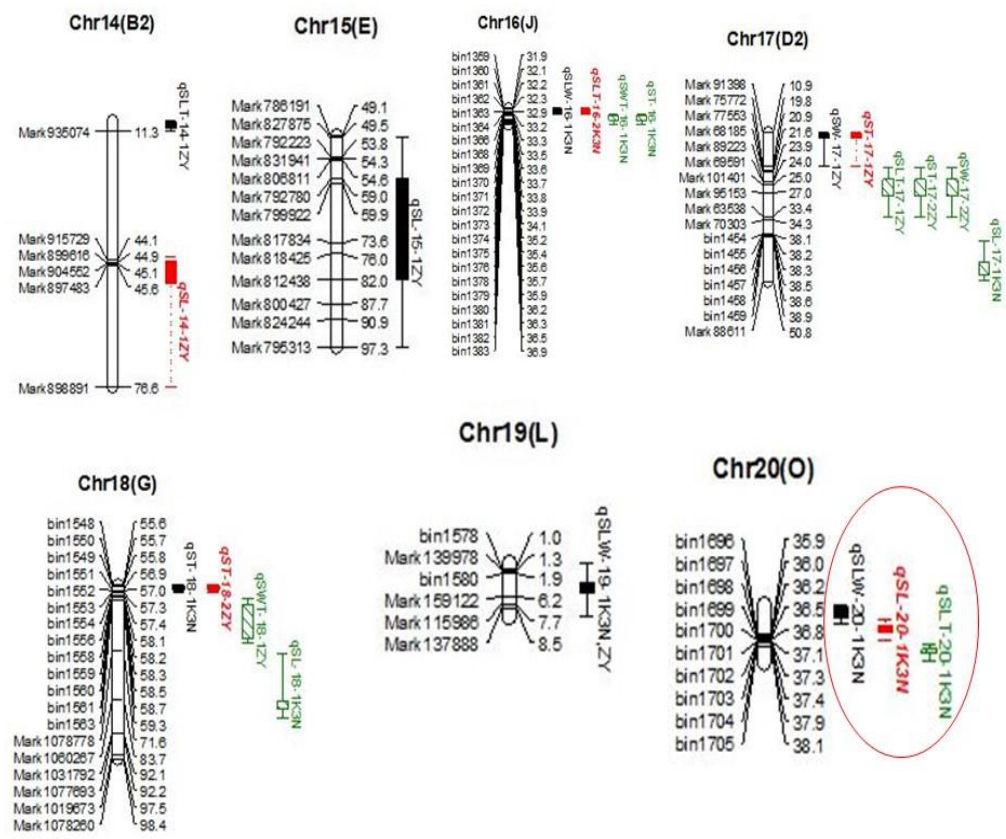
Figure 2. Location of quantitative trait loci (QTLs) on the genetic linkage map of the ZY and K3N RIL populations. Distances among markers are indicated using the physical location to the right of the linkage groups; names of markers are shown on the left. Only those SNP / SLAF markers are shown that were in and around the QTL regions. The red circles indicate the four QTL hotspots / clusters. Colored bars represent different QTLs.